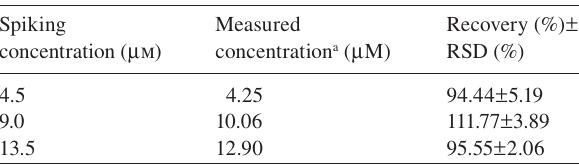
Table 1 Results obtained for TU analysis from spiked waste water